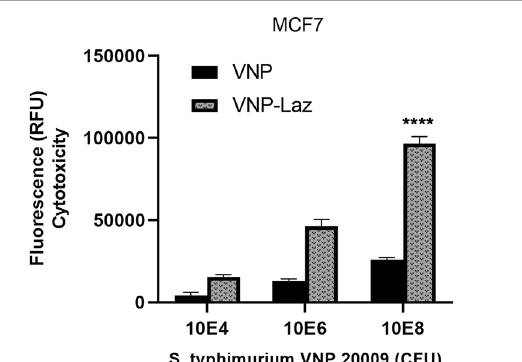
Fig. 3 Cytotoxic effect of the S. typhimurium VNP20009 expressing Laz (VNP‑Laz) on tumor cells in vitro. Monolayers of breast cancer cells MCF‑7 were co‑cultured with increasing bacterial densities (104, 10 6 , or 10 8 cfu) of VNP alone or VNP‑Laz under hypoxic conditions for 24 h. Apoptosis was assessed using caspase 3, 7 homogenate assay. All data are shown as mean s.e.m and represent data from ± three independent experiments n 3. *P < 0.0001 with respect to the = control groups at the same concentration